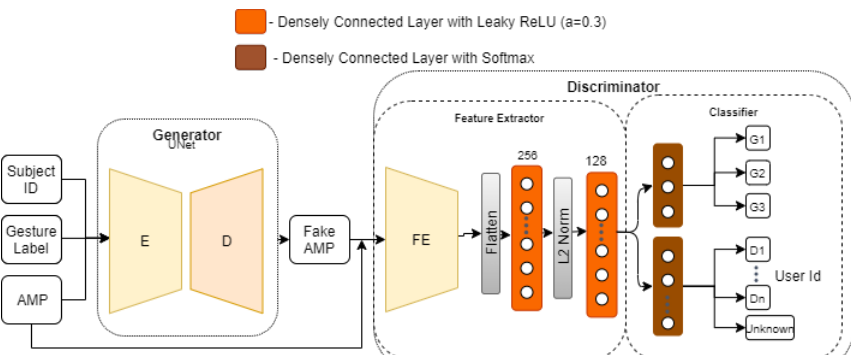
Figure 6. Adversarial network model.